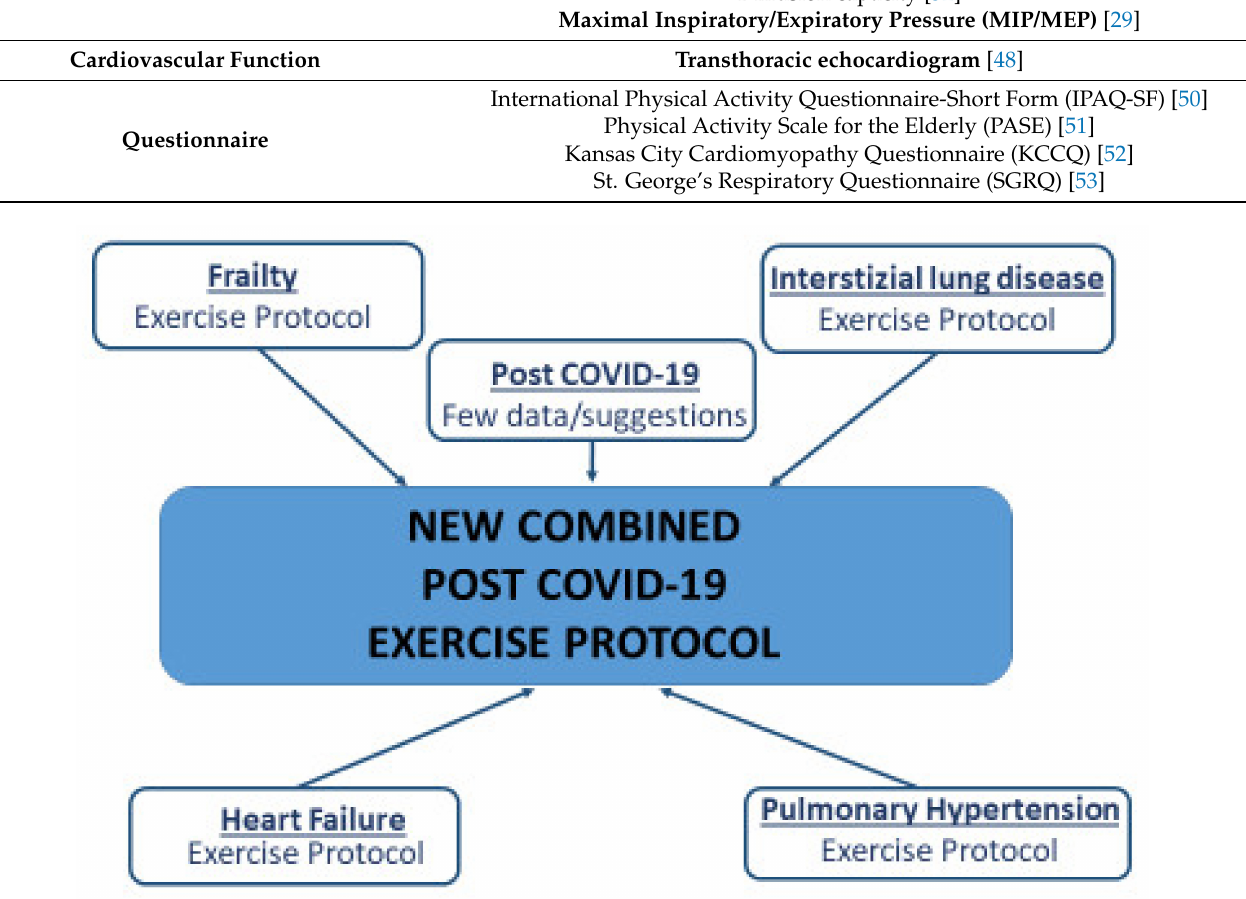
Figure 1. The “new combined post COVID-19 exercise protocol” construction